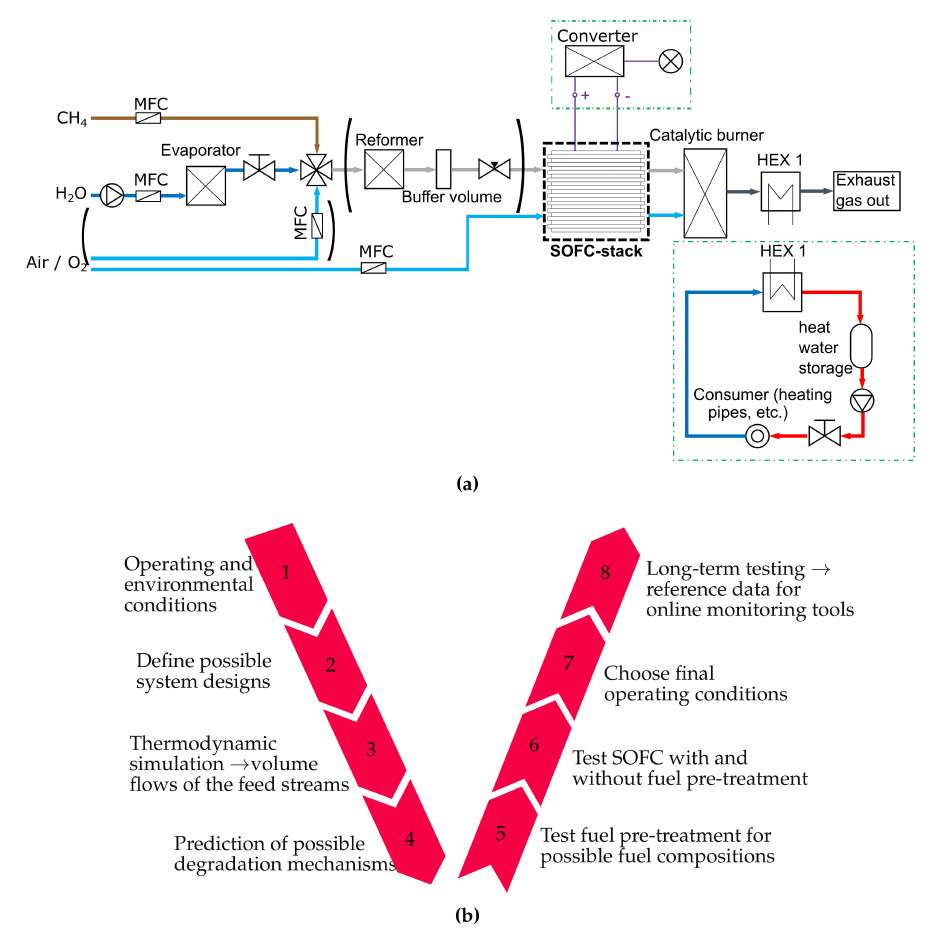
Figure 1. ( a ) Design scheme of the SOFC stand-alone system (HEX 1 is a gas-water heat exchanger) ( b ) V- model of the SOFC-system design